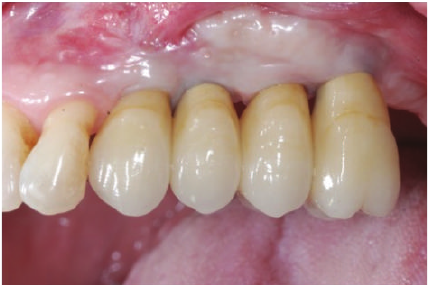
Figure 13: Two-year clinical analyses show a good healing of the soft